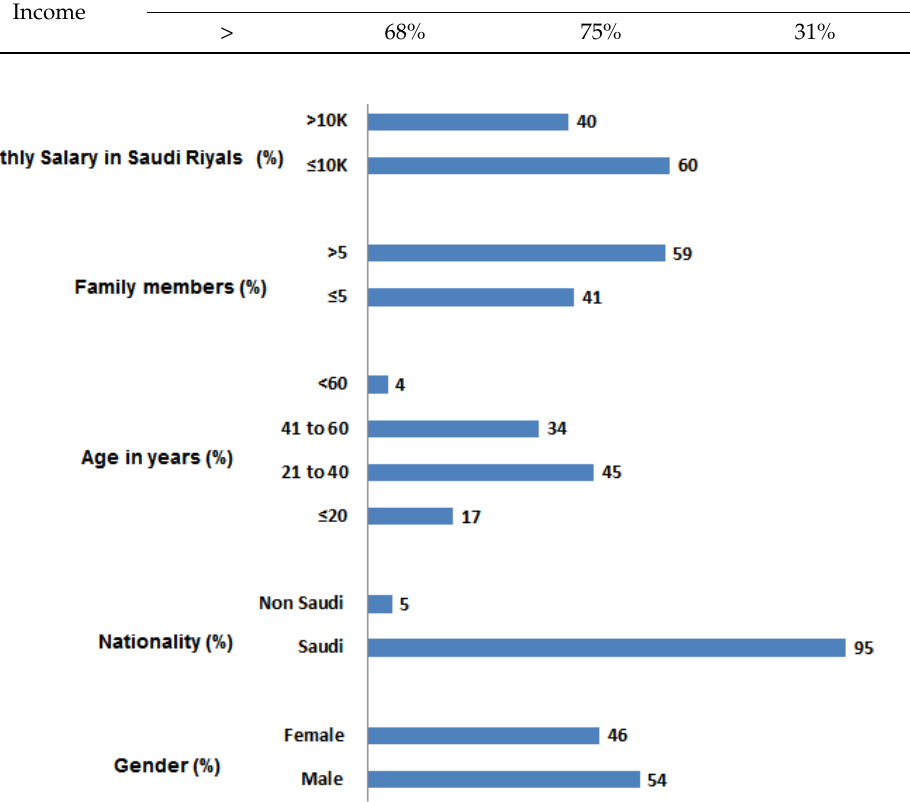
Figure 1. Distribution of participants based on the region in Saudi Arabia.